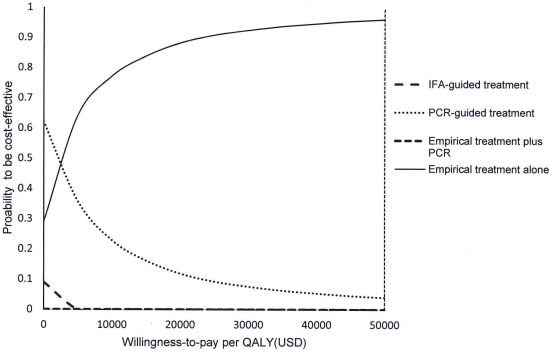
Acceptability curves of four treatment strategies to be cost-effective versus willingness-to-pay per QALY.